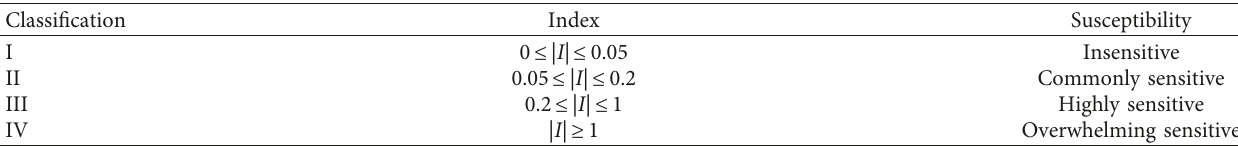
Figure 16: Variation of rainfall infiltration depth in the tailing slope with the changes of rainfall duration and infiltration coefficient. Table 3: Parameter sensitivity classification.